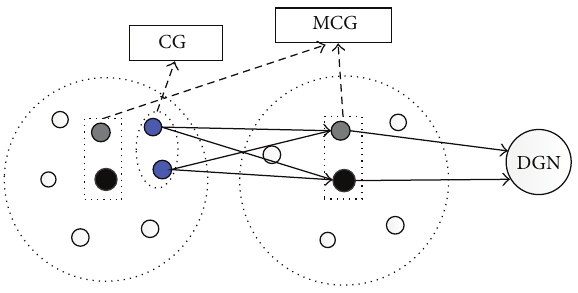
Figure 4: A two-hop virtual MIMO transmission of